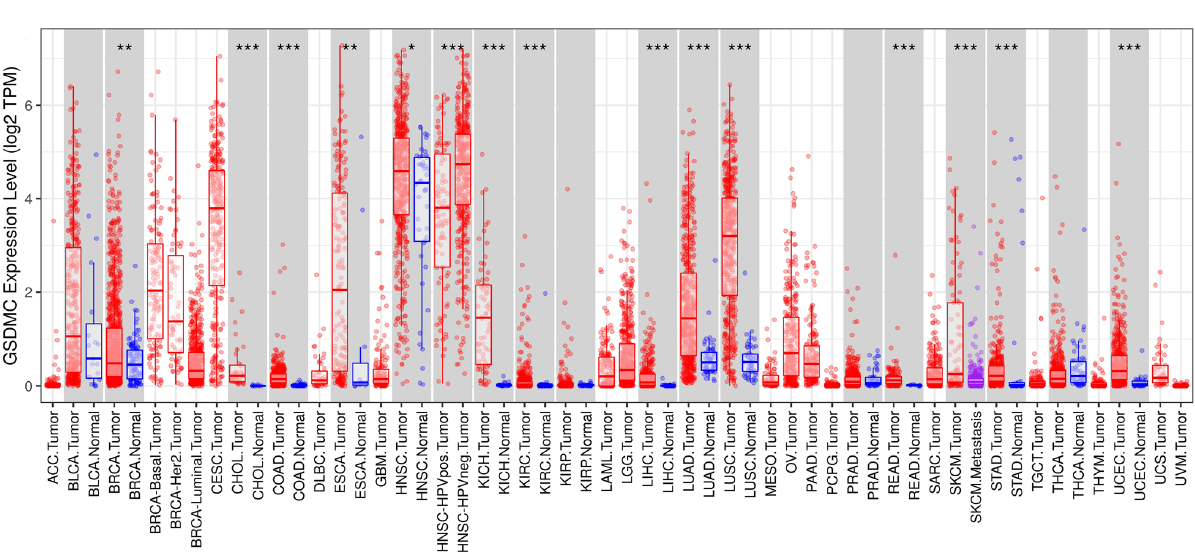
Figure 3. GSDMC expression levels in different tumor types from TCGA database were determined by TIMER. * P < 0.05, ** P < 0.01, *** P <